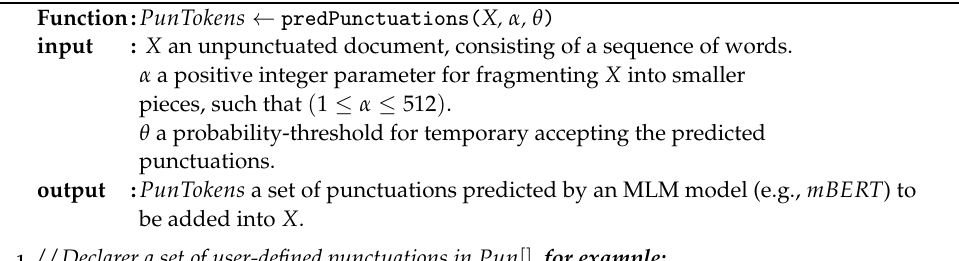
Algorithm 1: The proposed procedure for predicting punctuations in an unpunc- tuated document using an MLM model.